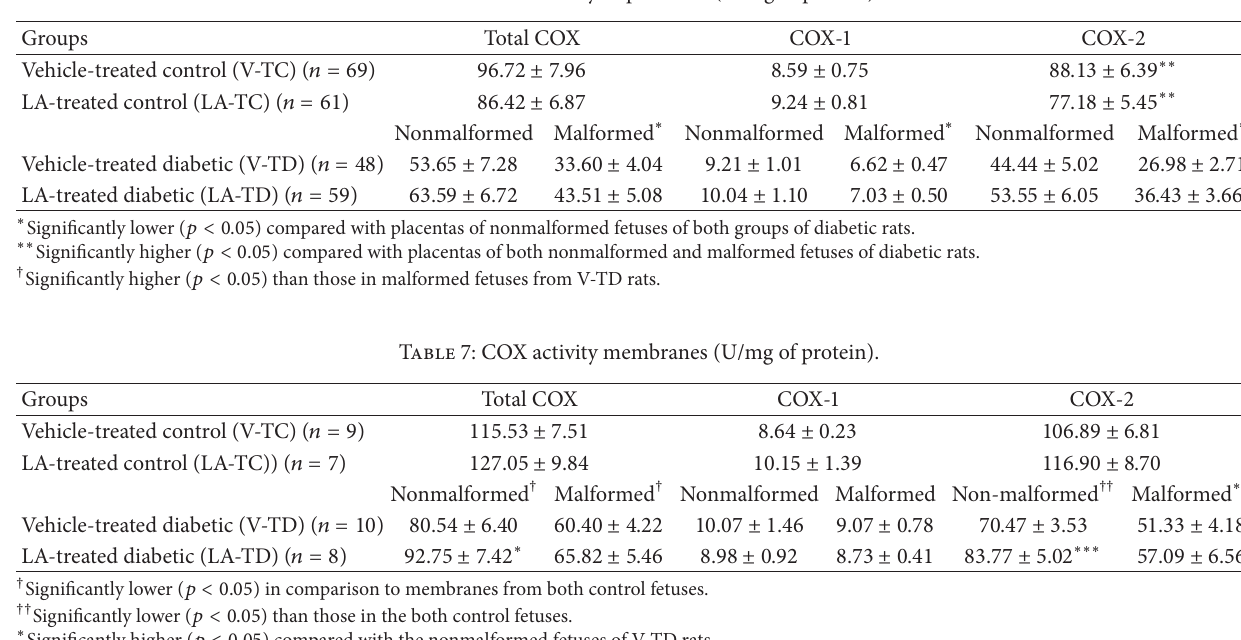
Table 6: COX activity in placentas (U/mg of protein).